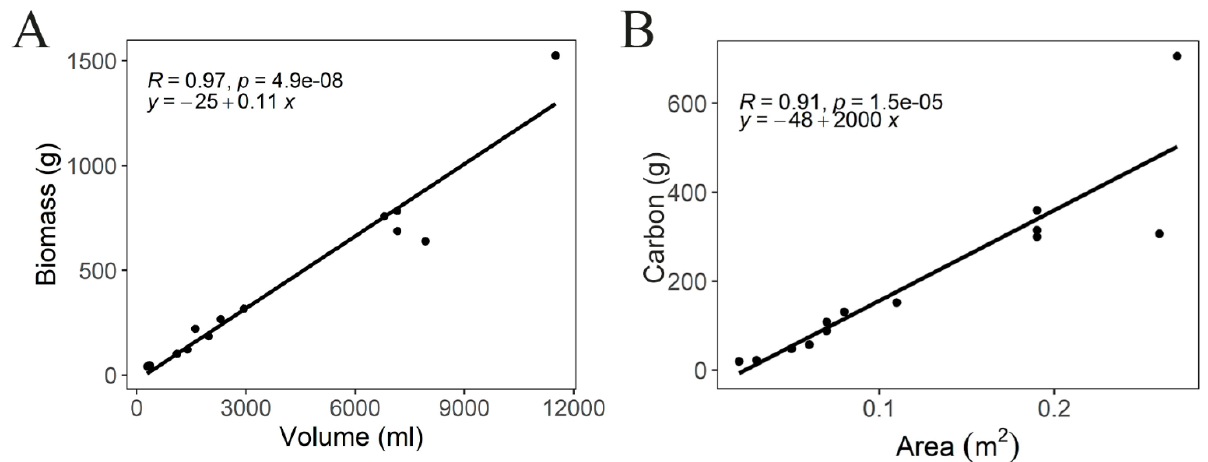
Figure 2. Relationships between (A) calculated 3D model volume and cushion biomass, and (B) calculated 3D model area and carbon content per square metre, for 13 individual cushions of Plantago rigida